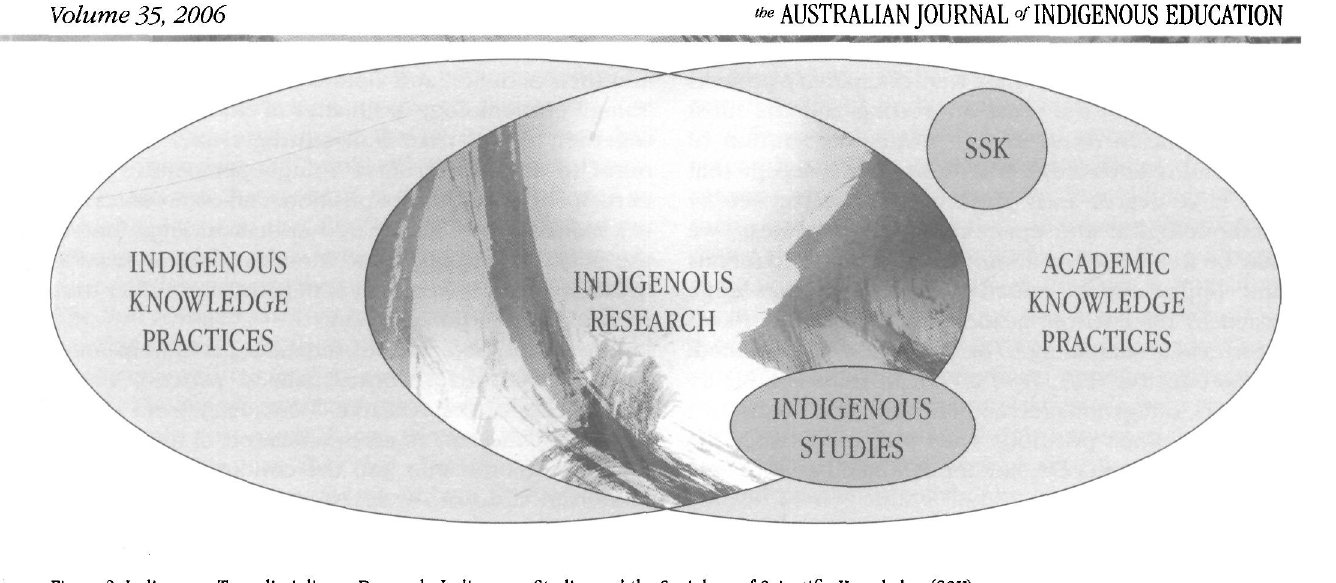
Figure 2. Indigenous Transdisciplinary Research, Indigenous Studies and the Sociology of Scientific Knowledge (SSK). it represents. It is invested in well-being, so it does not search for a distanced objective "God's eye